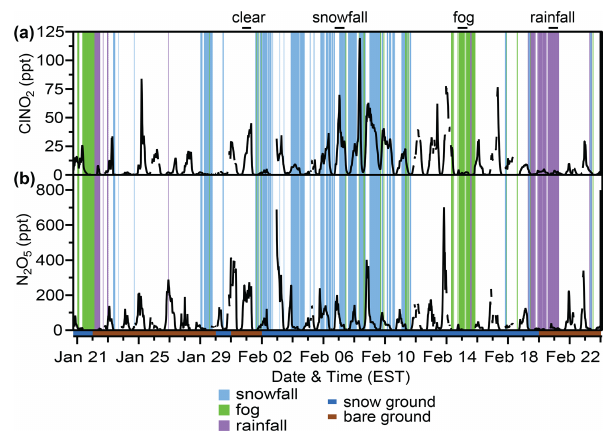
Figure 1. Mole ratios of 30min averaged (a) ClNO 2 and (b) N 2 O 5 during the campaign and occurrence of snowfall (light blue), fog (green), and rainfall (purple). The shading below the x axis repre- sents ground cover – snow (blue) or bare ground(brown). The black bars on the top of the plot show the selected case study nights for each weather event type. Between 18:00 and 08:00EST, where n is number of 30min periods, the air was clear 72% of the time ( n = 726; 363h), snowfall occurred 16% of the time ( n = 157; 78.5h), rainfall occurred 6% of the time ( n = 63; 31.5h), and fog occurred 6% of the time ( n = 58; 29h). The ground was snow- covered for 57% of the study (20d) and was bare for 43% of the study (15d). Figure S3 gives further details about the occurrence of weather events (rainfall, fog, snowfall) in relation to friction veloc- ity and ground cover.